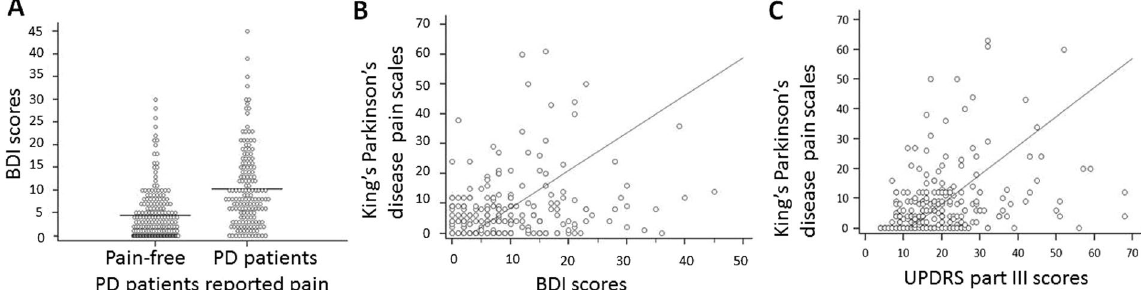
Figure 1. Clinical characteristics correlated with pain susceptibility and severity in patients with PD. ( A ) PD Patients with with pain had higher BDI scores than did those without pain. Pain intensity was defined by KPPS scores and was significantly correlated with depression severity (r = 0.201, P = 0.003; ( B )) and motor disability (r = 0.311, P < 0.001; ( C )) in patients with